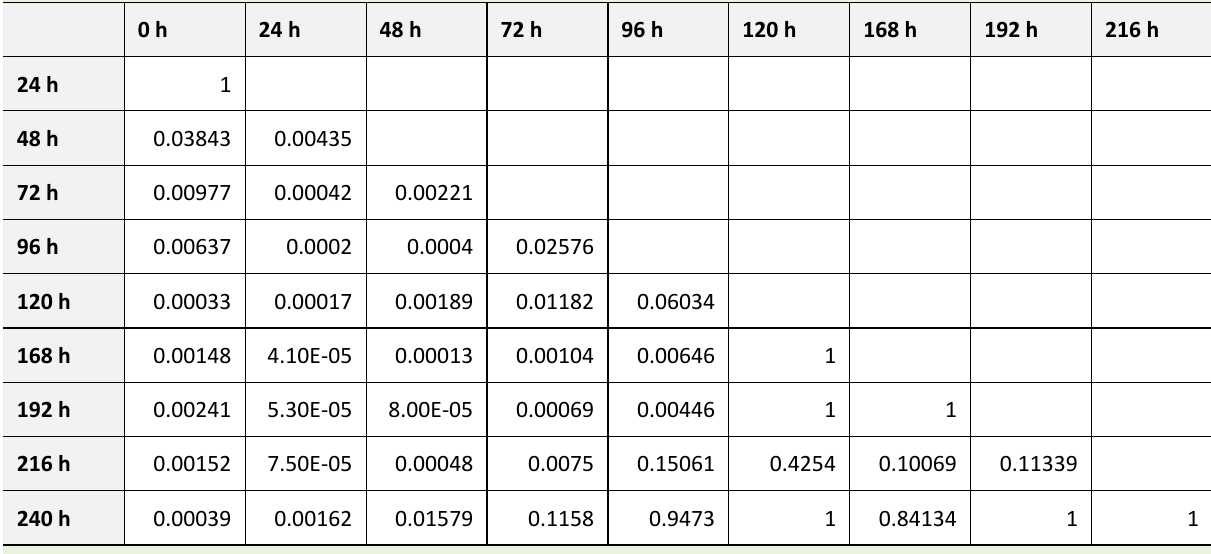
TABLE 1. Pairwise comparisons of novobiocin